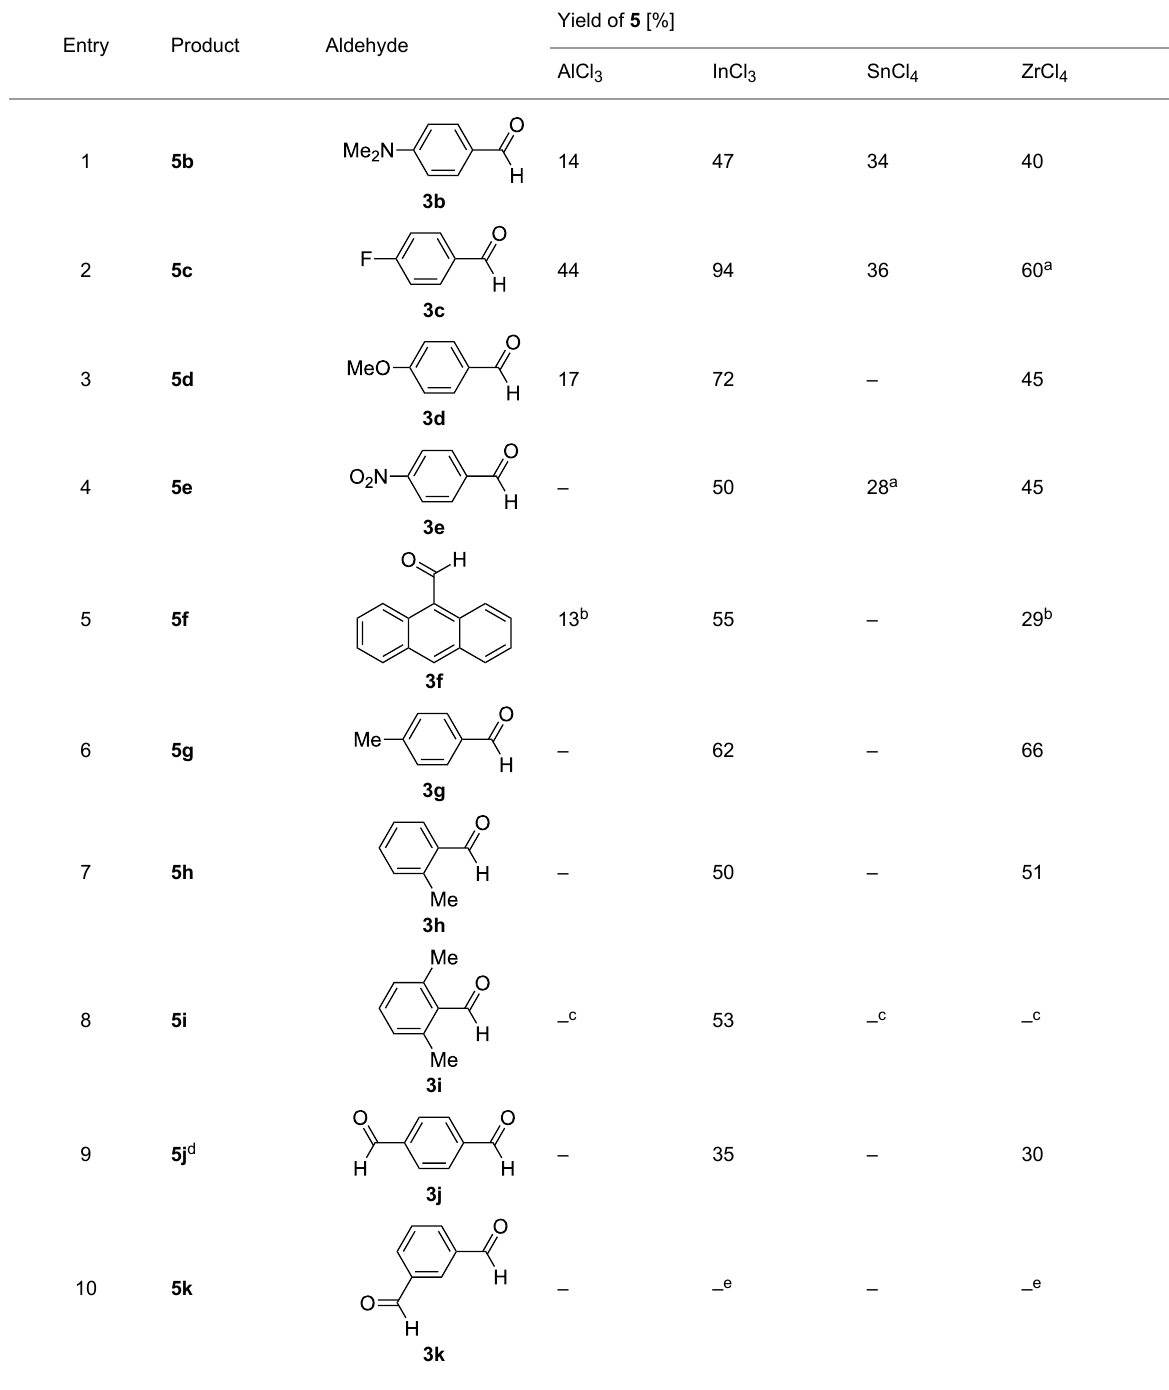
Table 5: Reactions of various aldehydes with propiophenone metal enolate (reaction time: 2 h, reaction temperature: 25 °C).